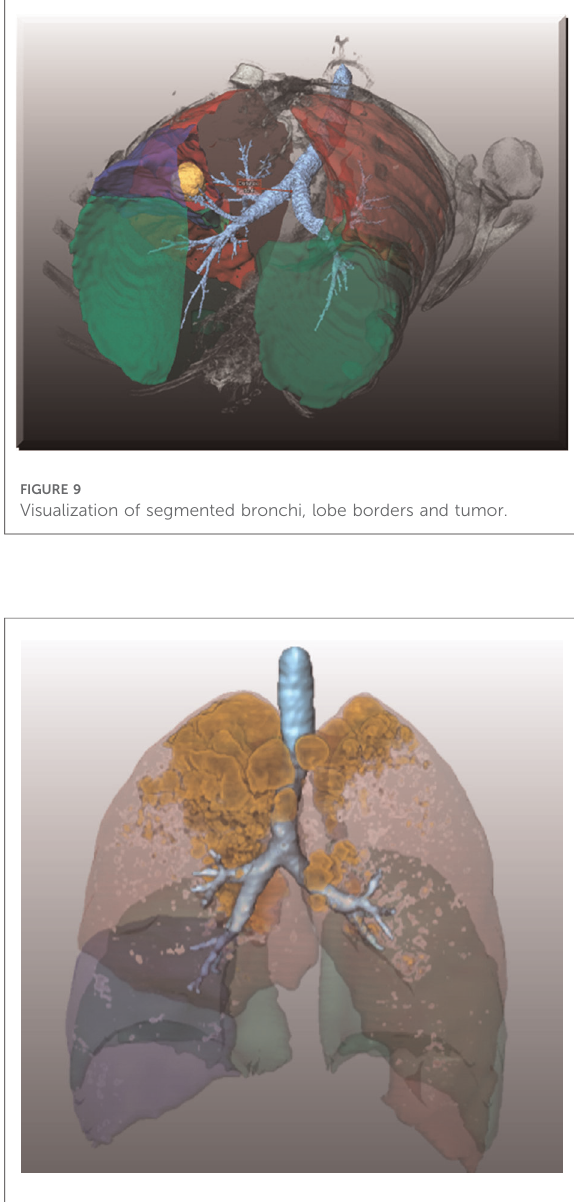
FIGURE 10 Visualization of segmented bronchopulmonary borders and emphysematous